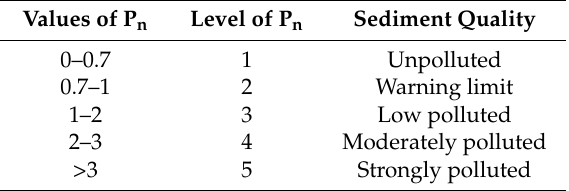
Table 1. Illustration Nemerow integrated pollution (P n ) levels related to sediment